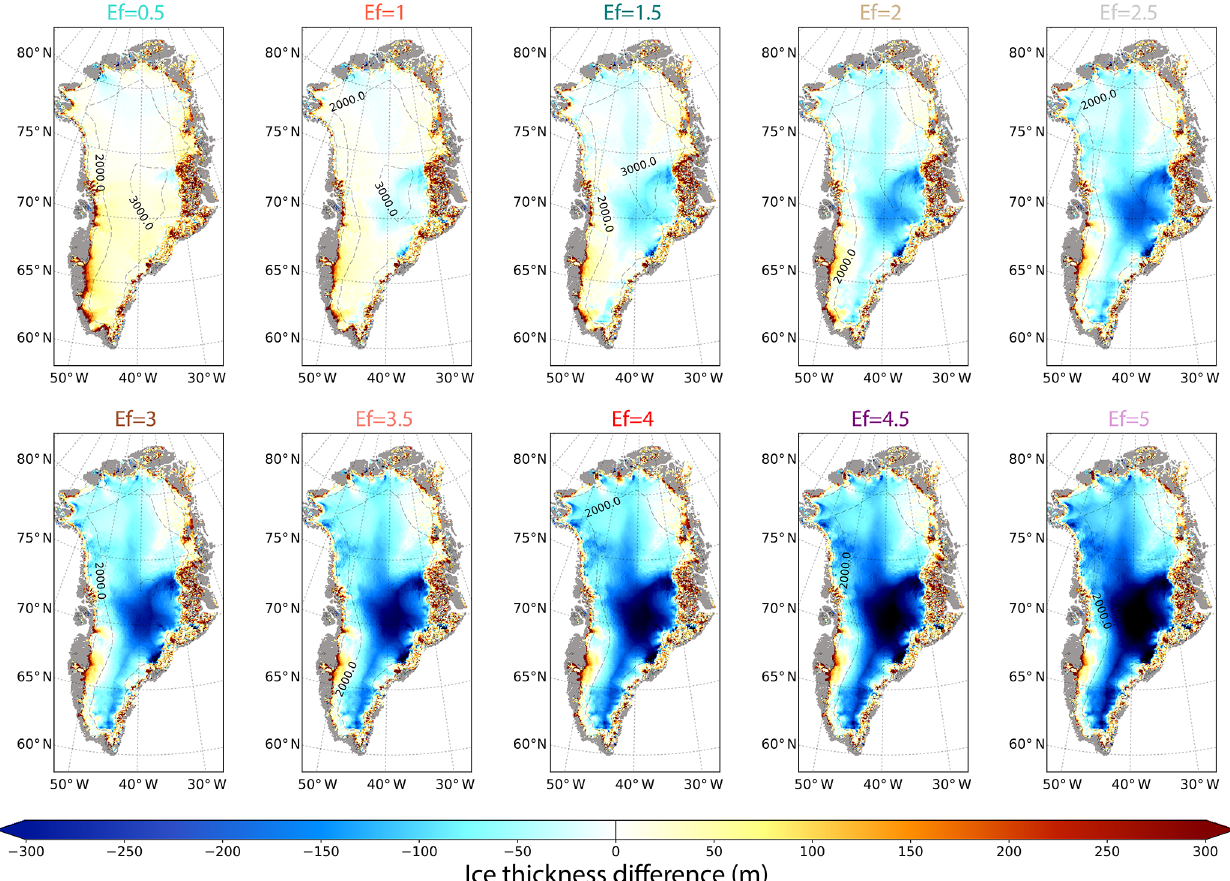
Figure 6. Difference between the simulated and the observed (Bamber et al., 2013) ice thickness (metres) for Ef ranging from 0.5 to 5 for the iterative cycle Nb cycle that produces the lowest RMSE (Table 1). Here, Nb inv and Nb free are set to 20 and 200 years